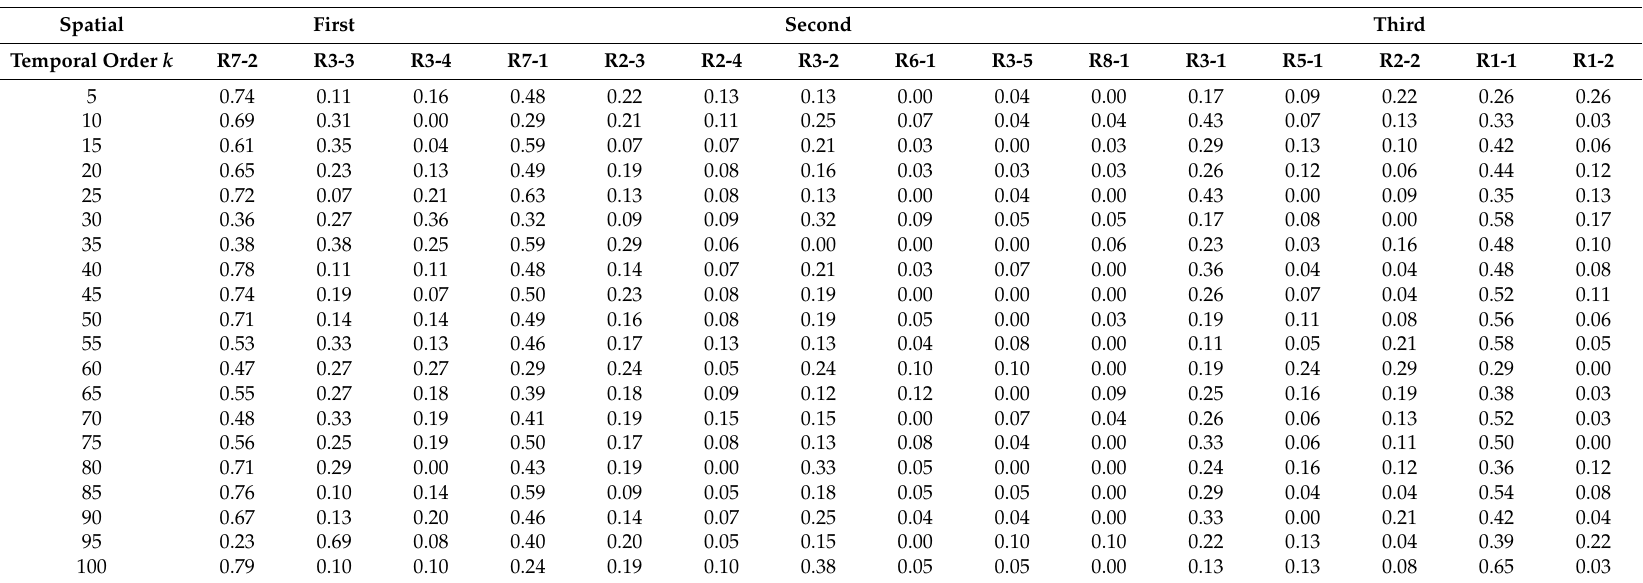
Table 2. The dynamic spatial